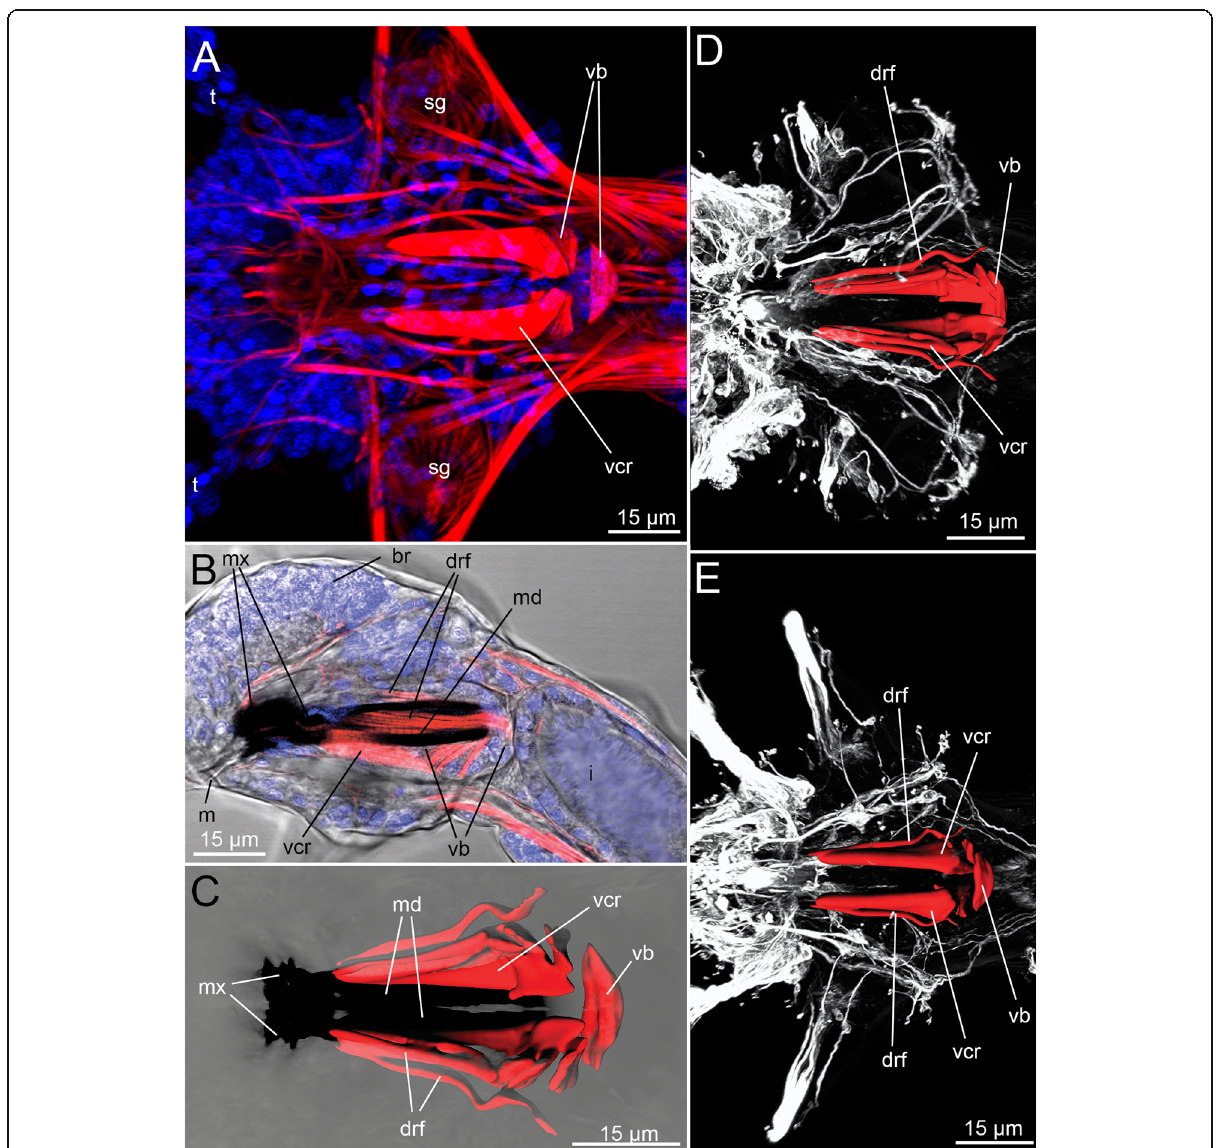
Fig. 3 Muscular apparatus serving the jaws of Histriobdella homari , confocal maximum projections. Jaws – black; nuclei – blue; musculature – red; tubulinergic nervous system – white. a. General view of the muscular apparatus. Ventral view. b. Lateral view of the anterior end, transmission light microscopy and cLSM. c. 3D reconstruction of the buccal muscles of the ventral pharyngeal organ. d. The buccal complex with the complete set of muscle elements of the anterior part of the body. Dorsal view. e. Ventral view of the buccal complex with the complete set of muscle elements of the anterior part of the body. br, brain; drf, dorsal rod flexor; sg, salivary gland; m, mouth; md, mandibula; mx, maxillae; t, tentacle; vb, ventral muscle bulb; vcr, ventral carrier